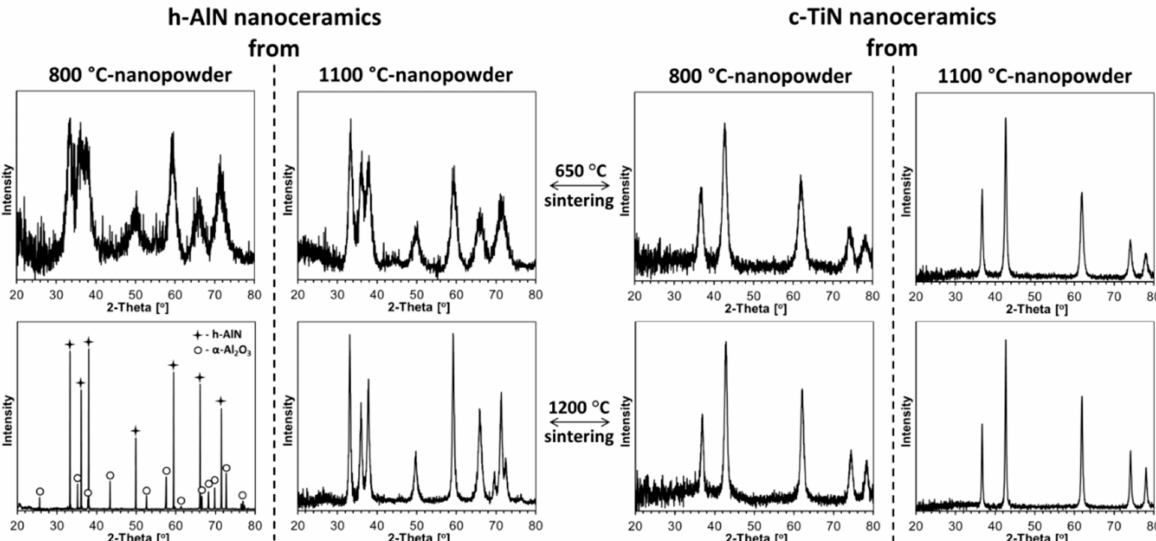
Figure 9. XRD patterns of single nitride nanoceramics sintered from individual nanopowders of h-AlN ( left panel ) and c-TiN ( right panel ) at 650 and 1200 ◦ C, 7.7 GPa. Note some α -Al 2 O 3 content in bottom corner of left panel for non-standard partially oxidized AlN-800 ◦ C powder then sintered at 1200 ◦